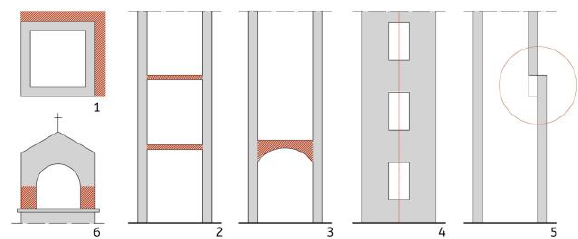
Figure 2. Explanatory schemes of geometric vulnerability indicators: 1. asymmetrical constraint; 2. empty tower; 3. vault in ground floor; 4. aligned openings; 5. discontinuous vertical wall; Figure 3. The church of San Giuseppe in Aci Castello 6. slender piers.